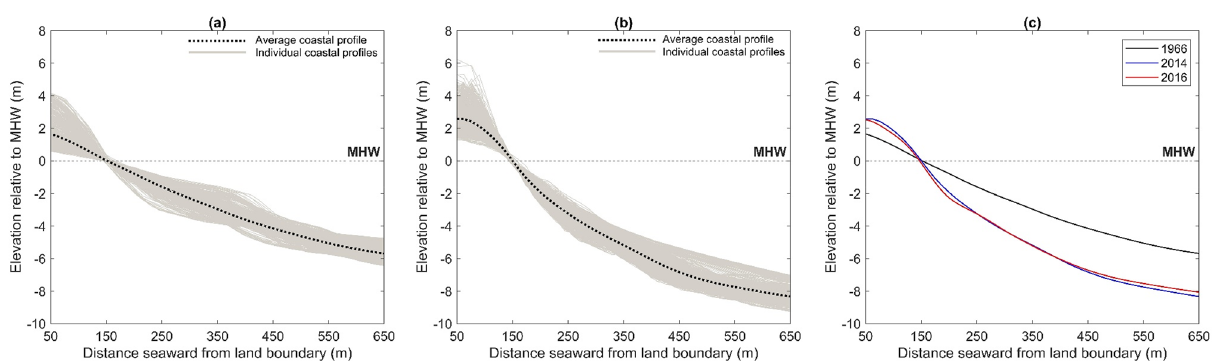
Figure 8. Temporal comparison of the average coastal profile morphology at the test site. ( a ) The 1966 coastal profile envelope and average coastal profile. ( b ) The 2014 coastal profile envelope and average coastal profile. ( c ) Compares the 1966, 2014, and 2016 average coastal profiles. The average coastal profile is the average of individual cross-shore profiles sampled every 15 m longshore. The individual cross-shore profiles incorporated in ( a,b ) illustrate the coastal profile